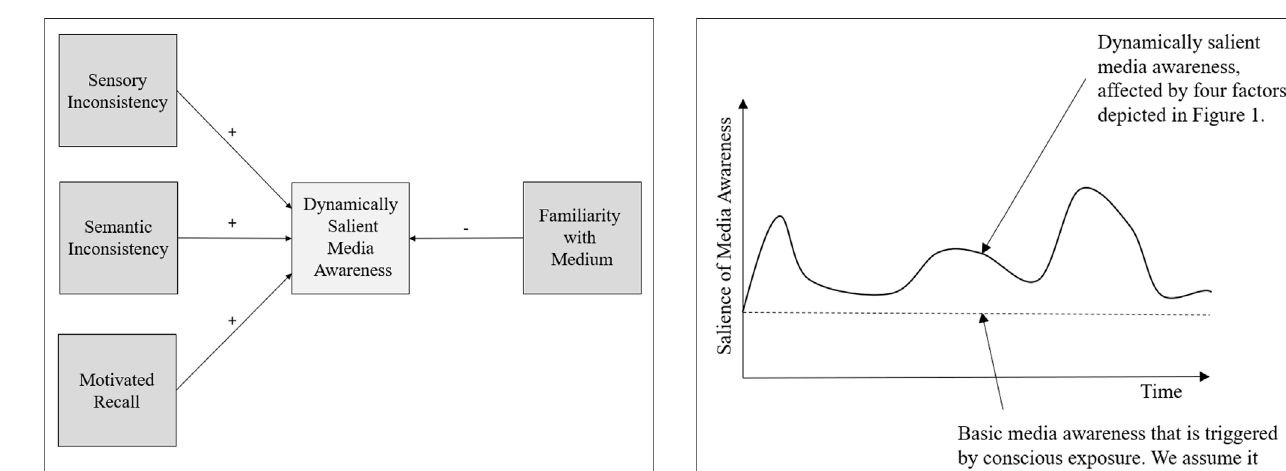
FIGURE 1 | Factors triggering (+) and factors reducing (-) dynamically salient media awareness. On the left, sensory inconsistency and semantic inconsistency are possible features of VR/XR, and motivated recall is a user factor that might enhance the salience of dynamical varying media awareness. On the right, familiarity with the VR/XR is a user factor that likely reduces dynamically salient media awareness.